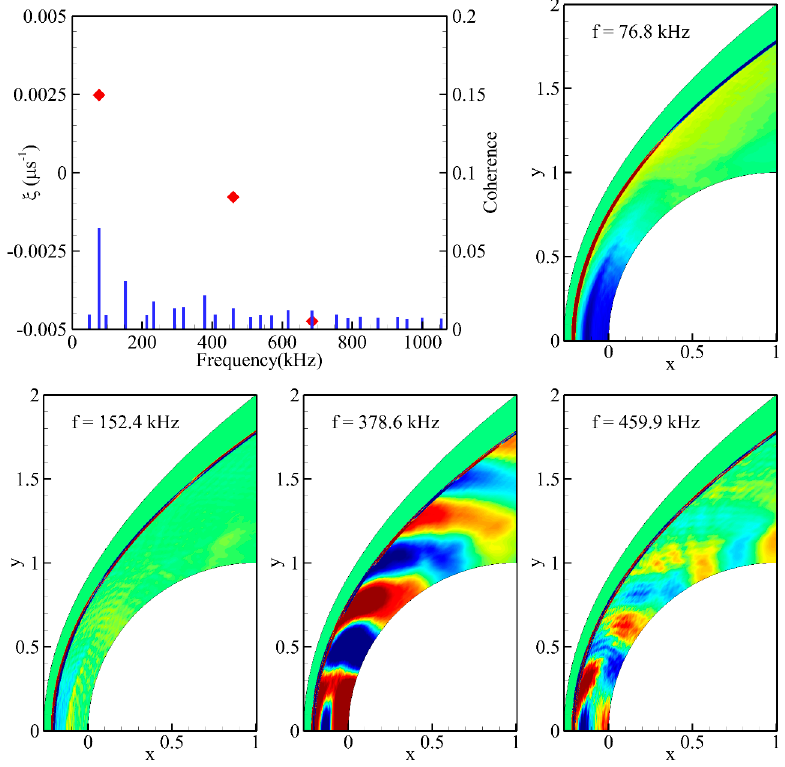
Figure 22. Temporal characteristics and spatial coherent structure of the flow field with DMD analysis for with the Dryer reaction mechanism for 400 × 600 grid resolution (red dot—growth factor; blue line—normalized coherence). DMD color scale is the same as Figure 19.